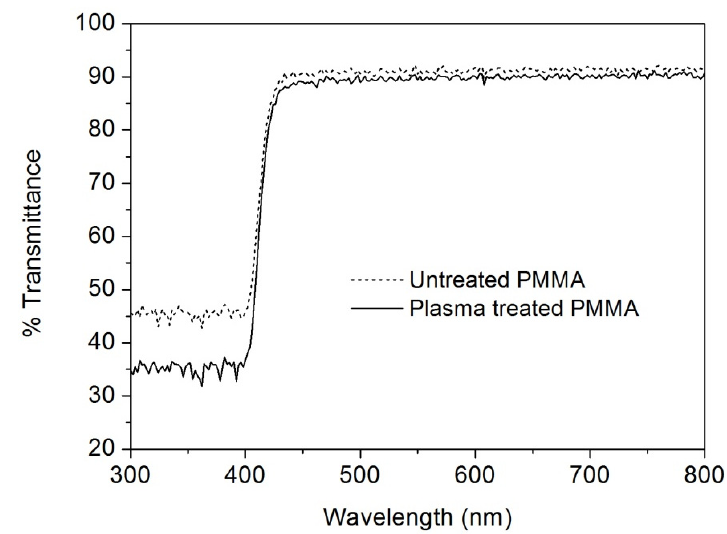
Figure 7. UV / VIS transmittance spectra of untreated (dash line) and plasma-treated (full line) PMMA lenses (peak power = 70 W, SF 6 pressure = 30 Pa, DC = 50%).